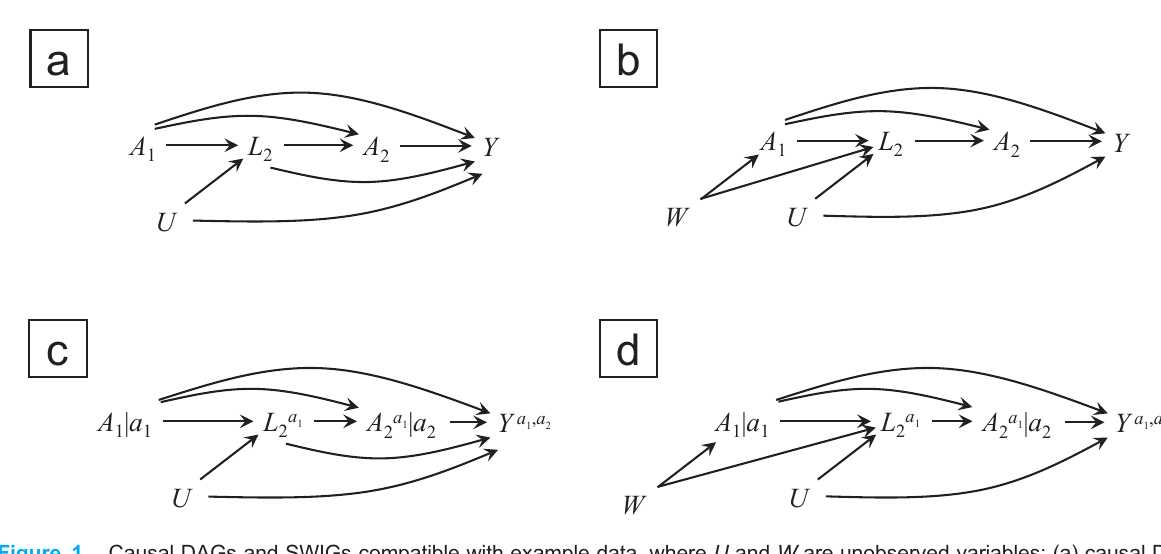
Figure 1. Causal DAGs and SWIGs compatible with example data, where U and W are unobserved variables: (a) causal DAG without W , in which A 1 – L 2 , A 1 – Y , and A 2 – Y are (conditionally) unconfounded given observed data; (b) causal DAG with W , in which A 1 – Y and A 2 – Y are (conditionally) unconfounded but A 1 – L 2 is confounded given observed data; (c) a “ template ” under intervention ( a “ template ” under intervention 1 , a 2 ) of SWIG that corresponds to causal DAG (a); (d) a ( a 1 , a 2 ) of SWIG that corresponds to causal DAG (b).